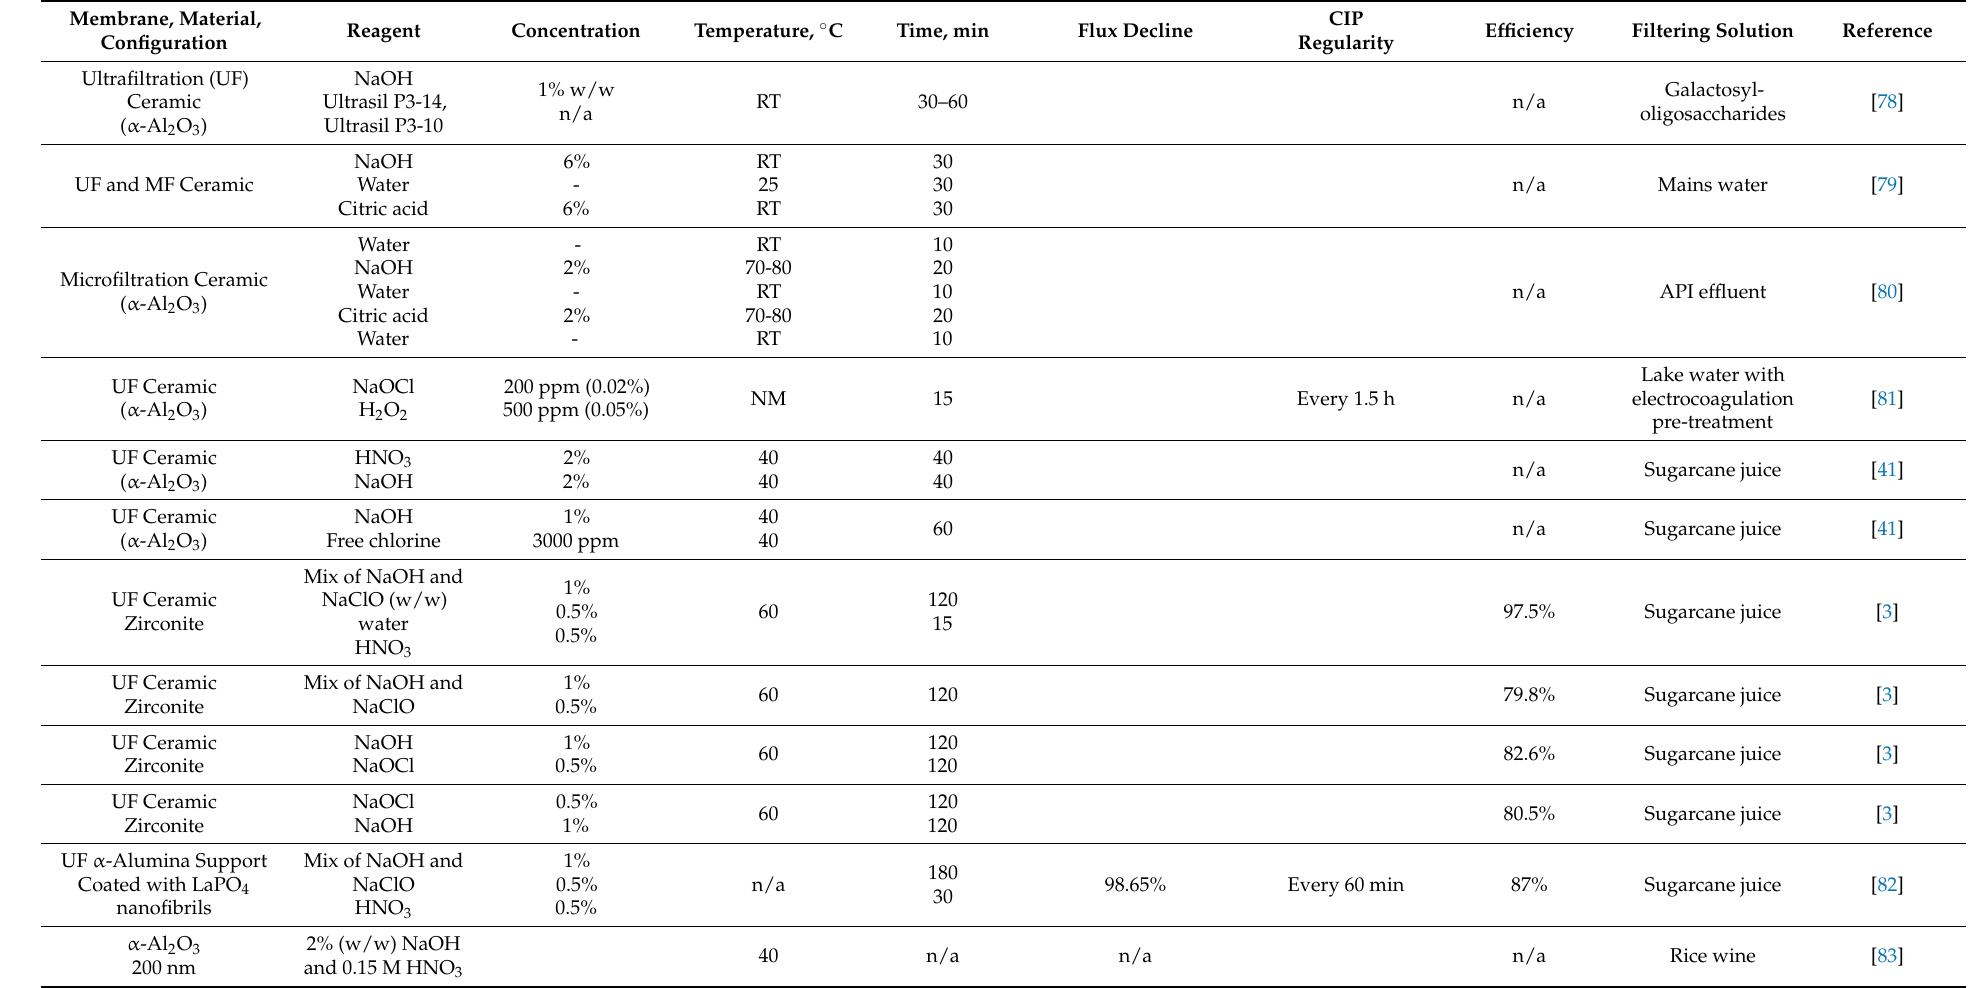
Table 3. Cleaning-in-place (CIP) procedures for ceramic ultrafiltration membranes. RT—room temperature, n/a—not